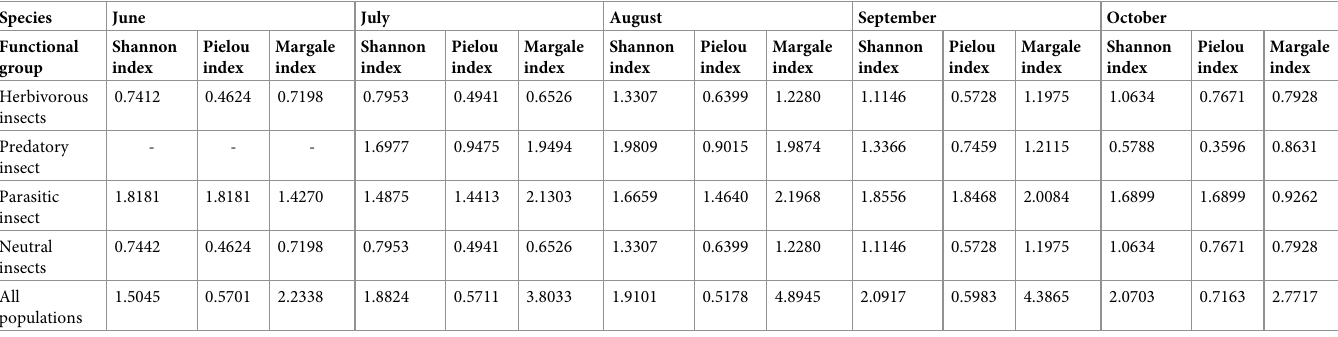
Table 3. Biodiversity characteristics of farmland insect community functional